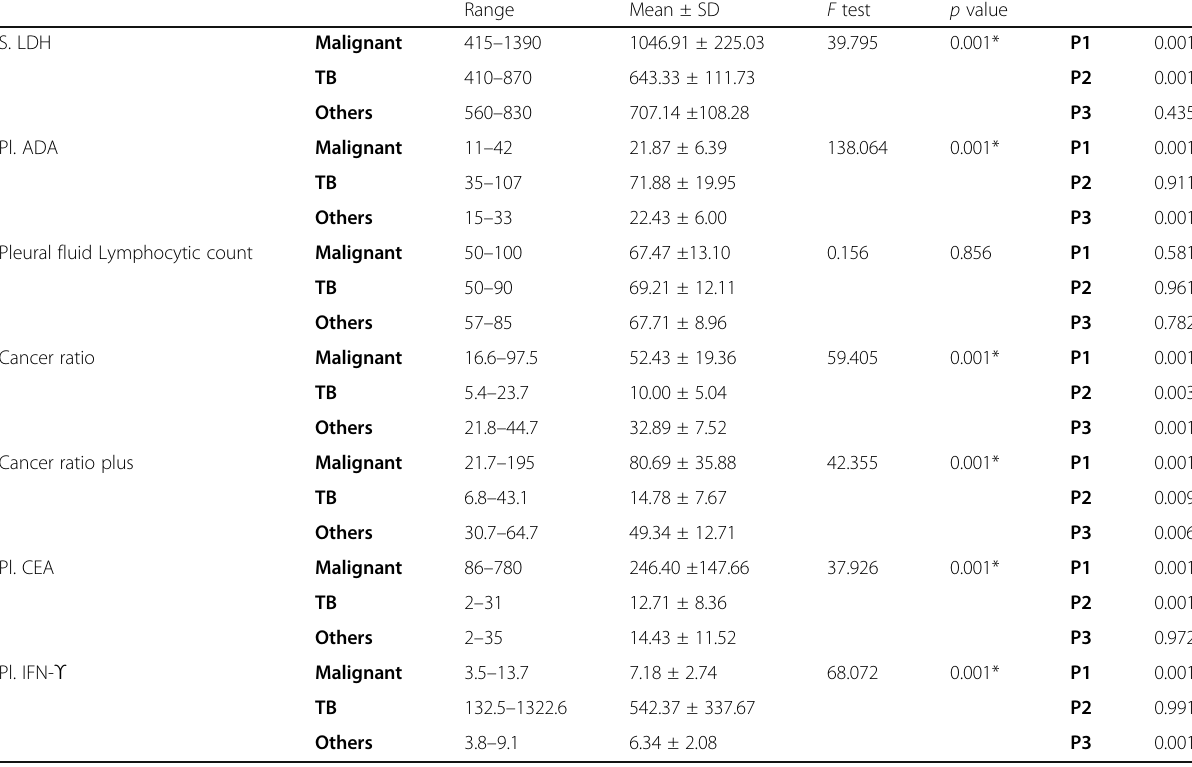
Table 1 Chemical characteristics of pleural fluid